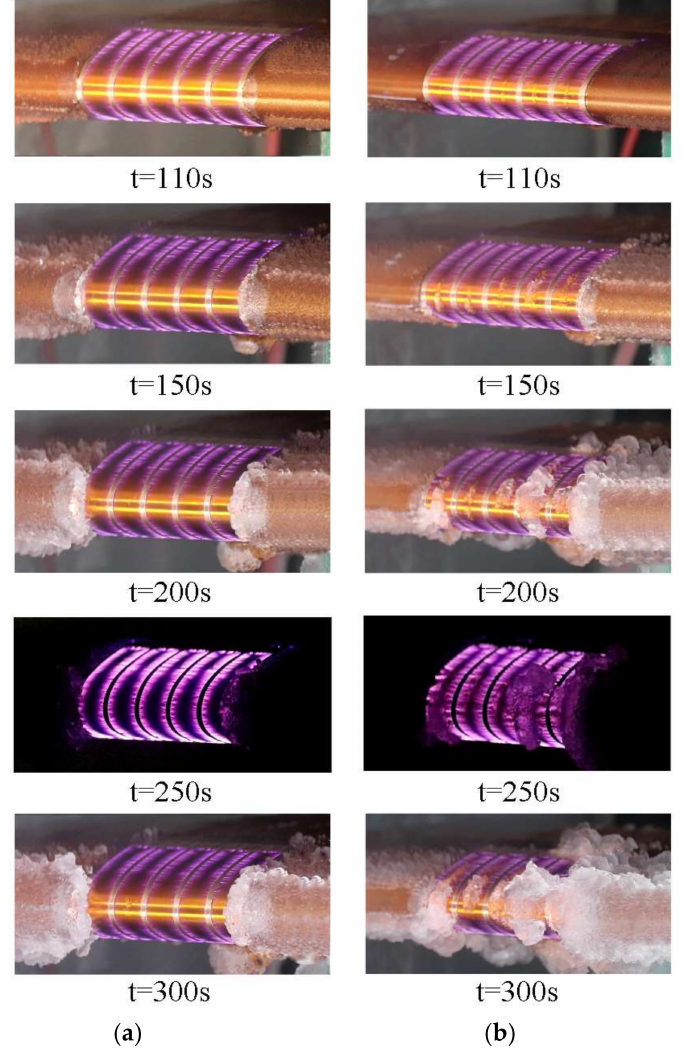
Figure 13. Dynamic anti-icing process of NS-DBD plasma actuator: ( a ) LV-HF discharge; ( b ) HV-LF